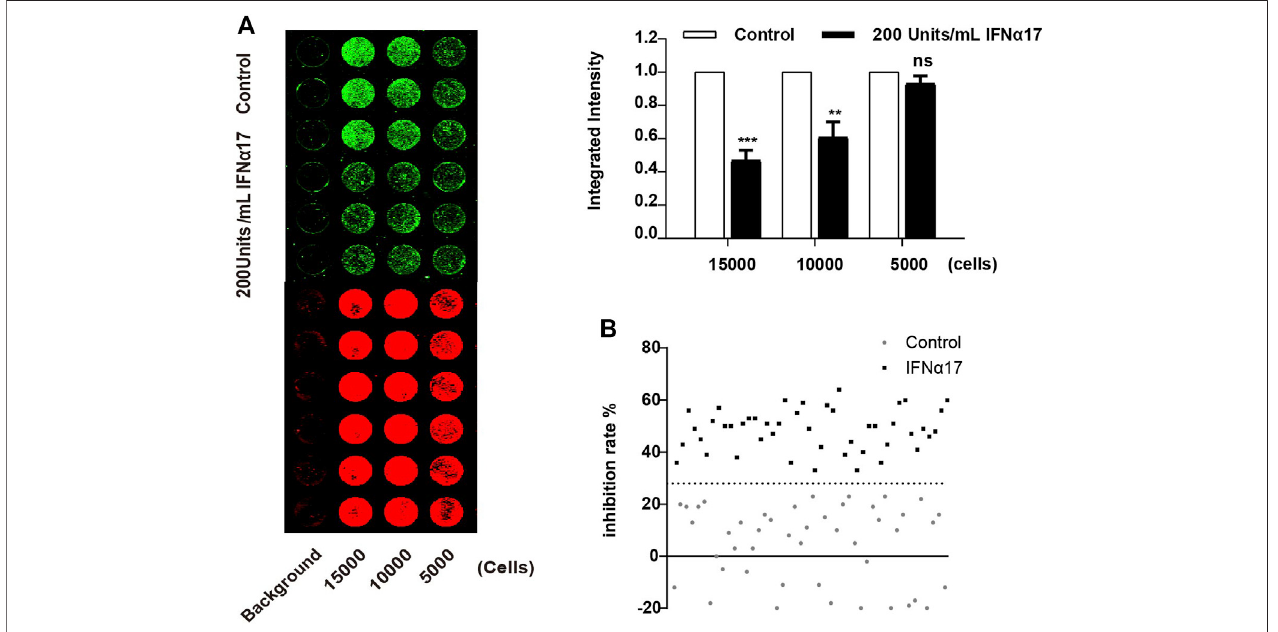
FIGURE2| OptimizationoftheICW assayforLINE-1 ORF1p expression inhibitor screening. (A) ,Optimizationofthecelldensity seeded inthe96wellplate.T-47D cells were seeded in 96 well plate at the concentration of 5,000, 10,000 and 15,000 cells per well, and then treated with IFN α 17 (200U/ml), 48 h later, ICW assay were performed(leftpanel),therelativeORF1pexpressionlevelwascalculatedbytheratiooftheintegratedintensityvalueofIFNtreatedcelltothatofDMSOtreatedcells(right panel). (B) , Determination of Z ′ factor of the ICW based screening assay. One-half plate of T-47D cells was incubated with IFN α 17 (200 units/mL) or PBS as a vehicle control for 48 h. Then the plate was scanned with the Odyssey system (LI-COR), the integrated fl uorescence intensities and Z ′ factor was calculated. All experiments were performed three times and statistical signi fi cance was determined using Students two-tailed t -test. * p < 0.05, ** p < 0.01.